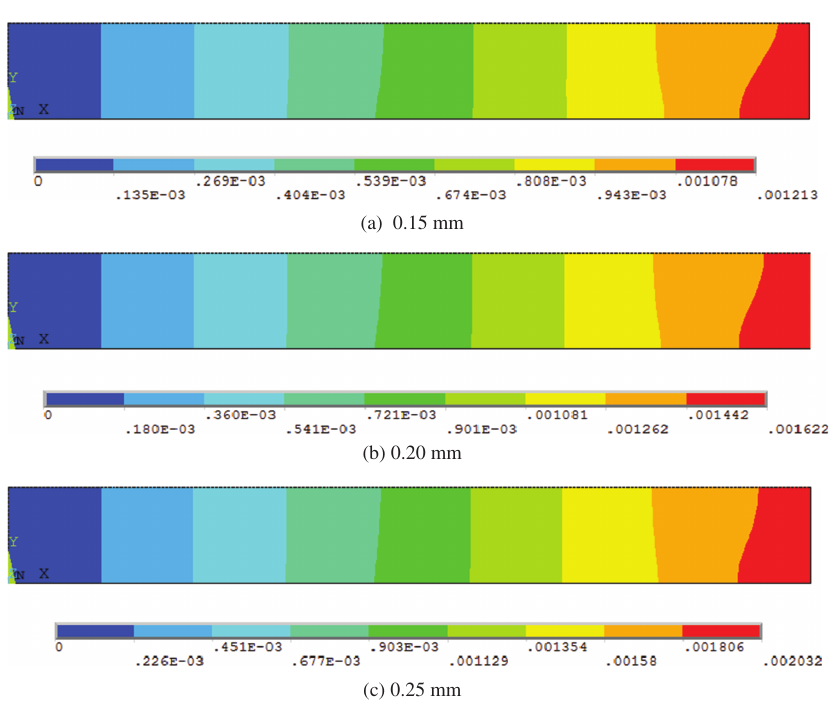
Figure 1: Temperature distribution in quarter cross-section of slab.